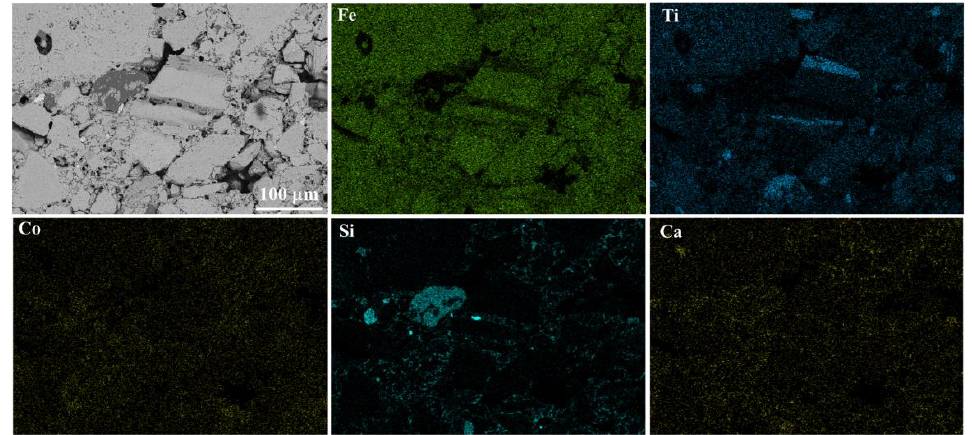
Figure 10. X-ray element mapping of CVTP with 6 wt % Co 2 O 3 addition.